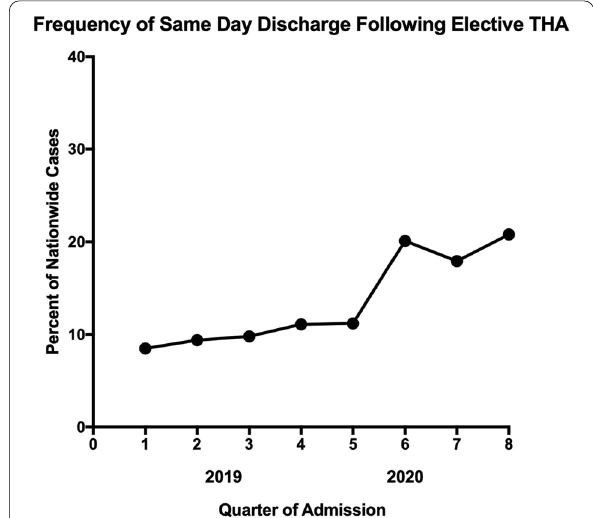
Fig. 2 The proportion of same day discharge increased by quarter from 2019 (Ranging from 8.5% to 11.1%) to 2020 (Ranging from 11.2% to